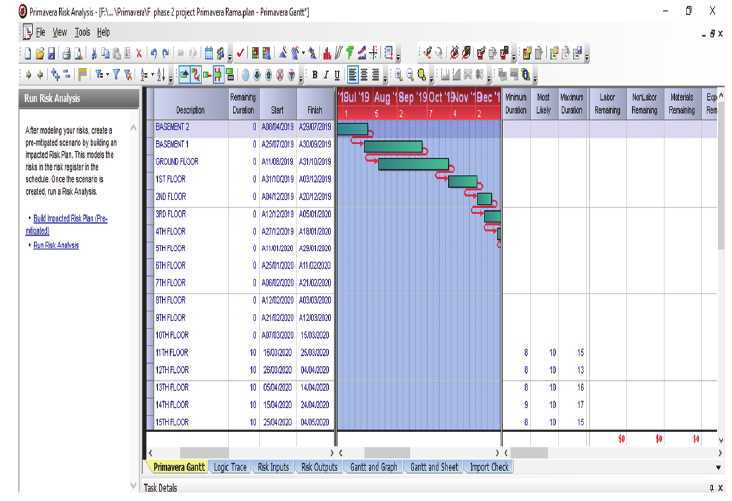
Fig. 1. Schedule Risk Model